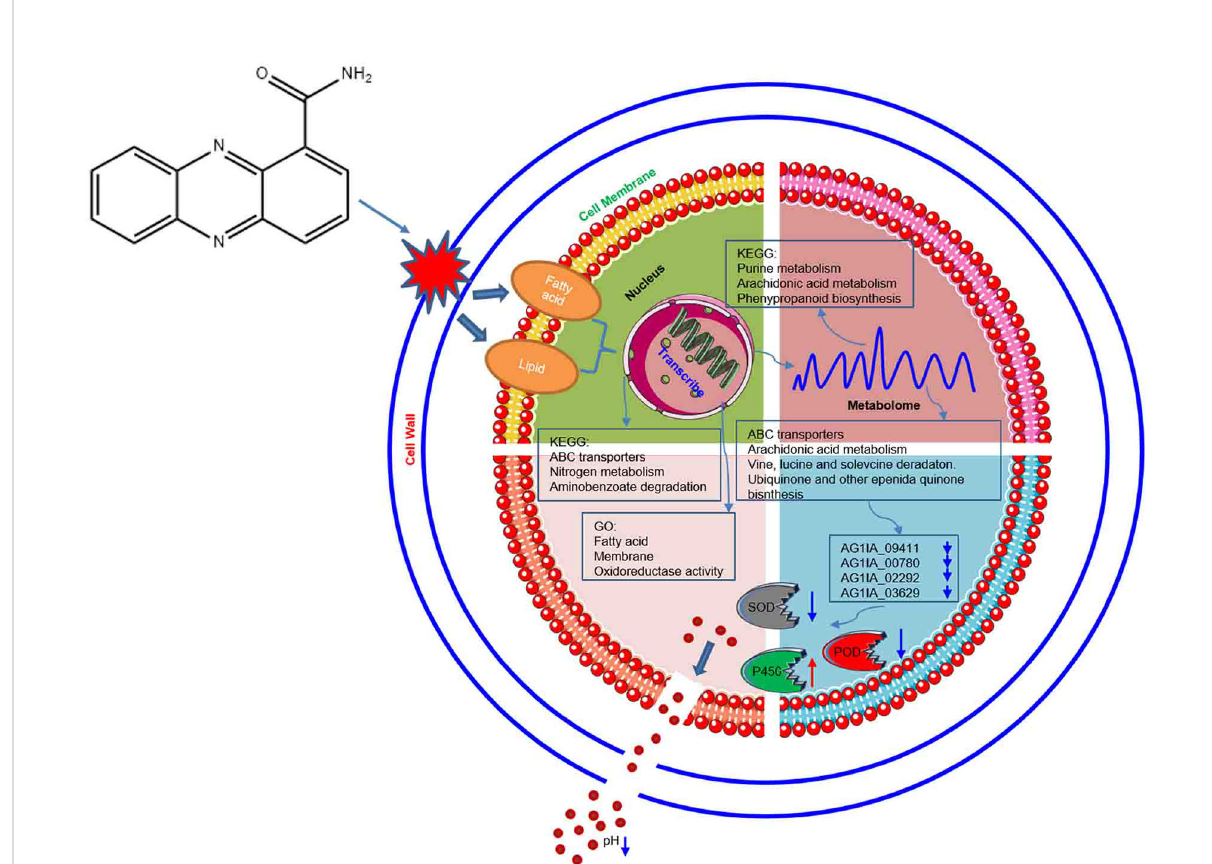
FIGURE 12 Model of molecular mechanisms via which the antifungal compound PCN inhibits R. solani